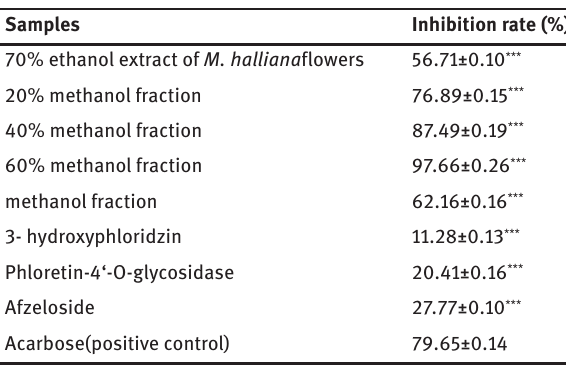
Table 3: Effects of different extract and compounds from M. halliana flowers in 2014 on α -glucosidase activity (n=3).